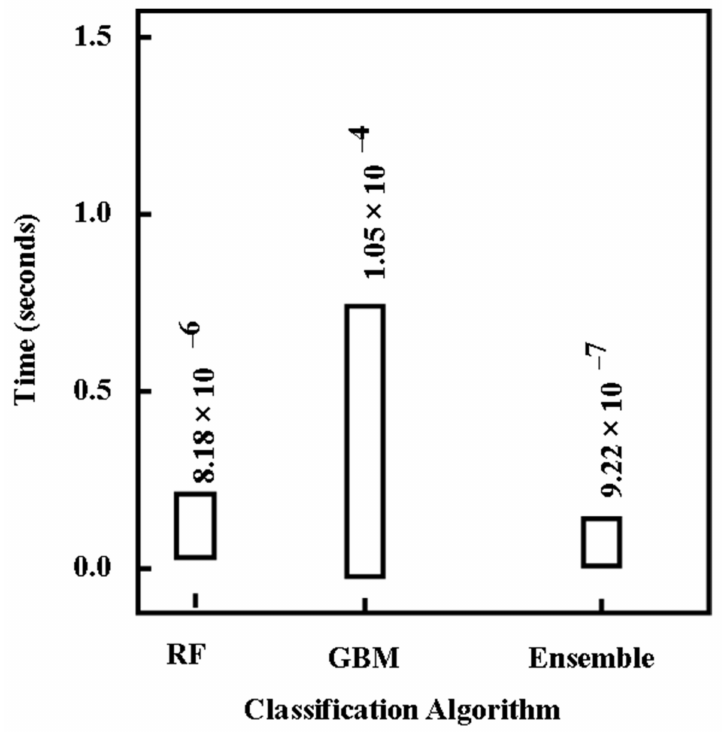
Figure 11. Average response times of classifiers.